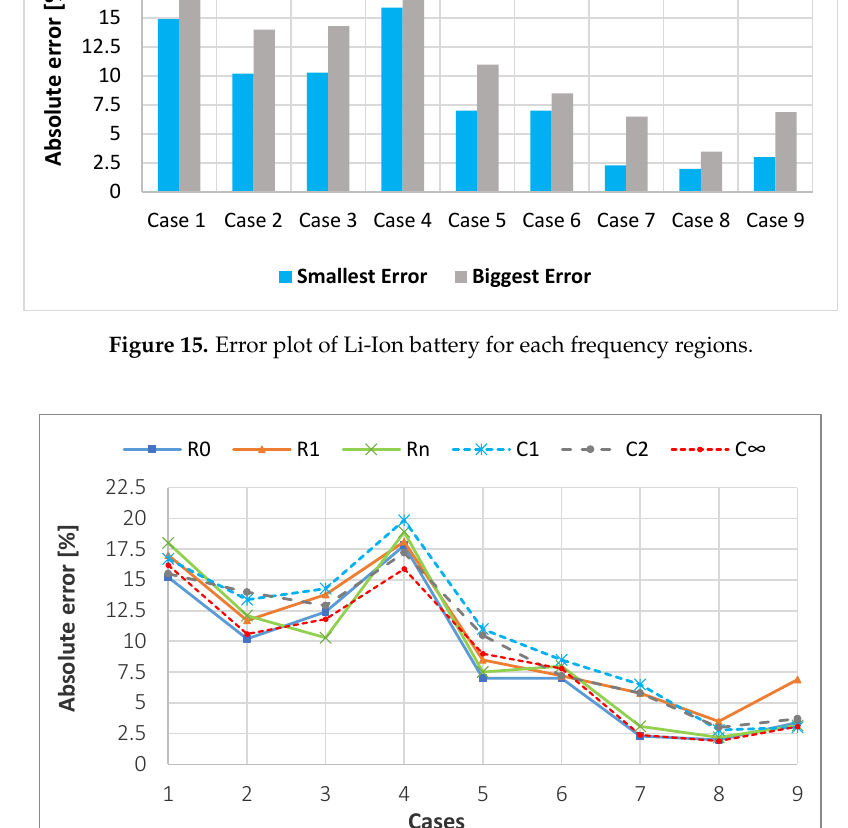
Figure 16. Error plot of Li-Ion battery for each of the parameters.